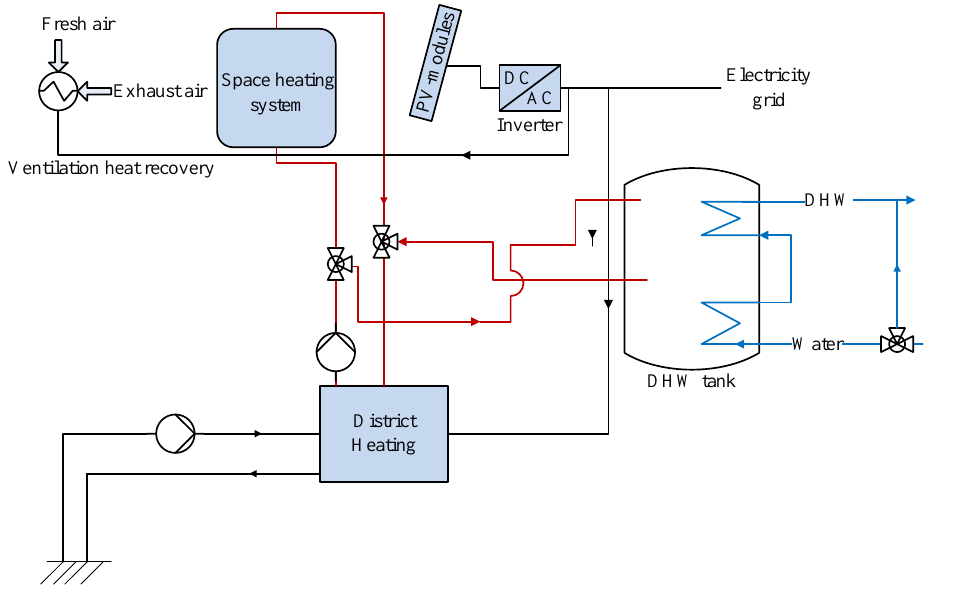
Figure 5. System schematics for building with DH and PV-system.